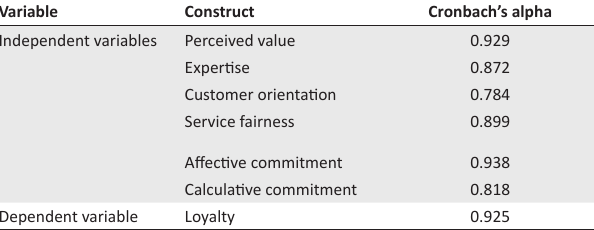
TABLE 2: Results of the Cronbach’s alpha